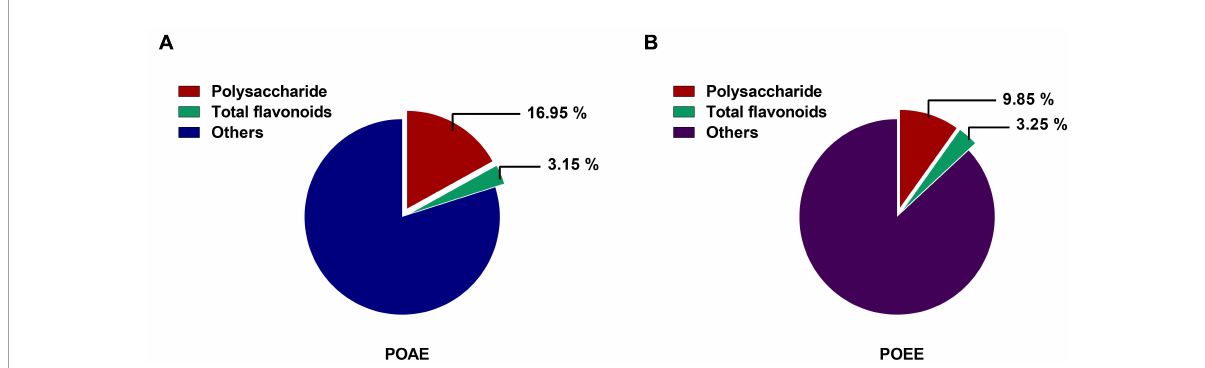
FIGURE1 Polysaccharide and total flavonoid extraction rates of POAE and POEE in this study. (A) Polysaccharide and total flavonoid extraction rates of POAE. (B) Polysaccharide and total flavonoid extraction rates of POEE. Absorbance was measured at least 3 times and calculated based on the standard products (Glucose and Rutin). The data were expressed as